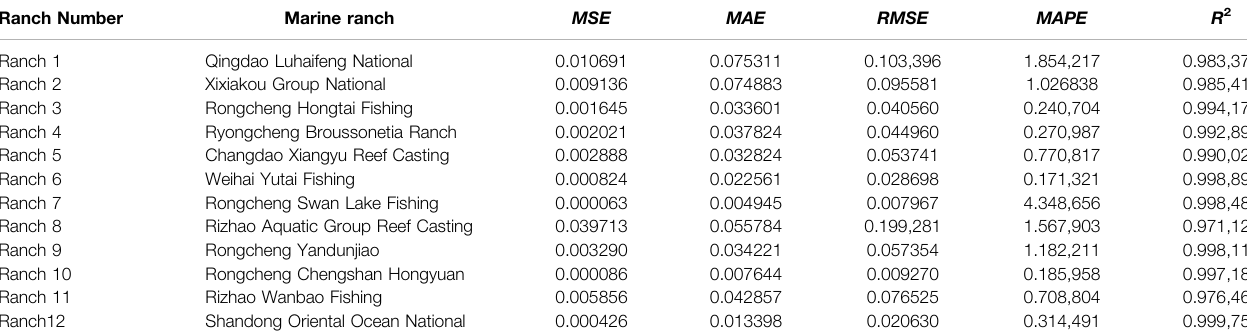
TABLE 2 | Prediction error evaluation indexes of 12 ranch models.